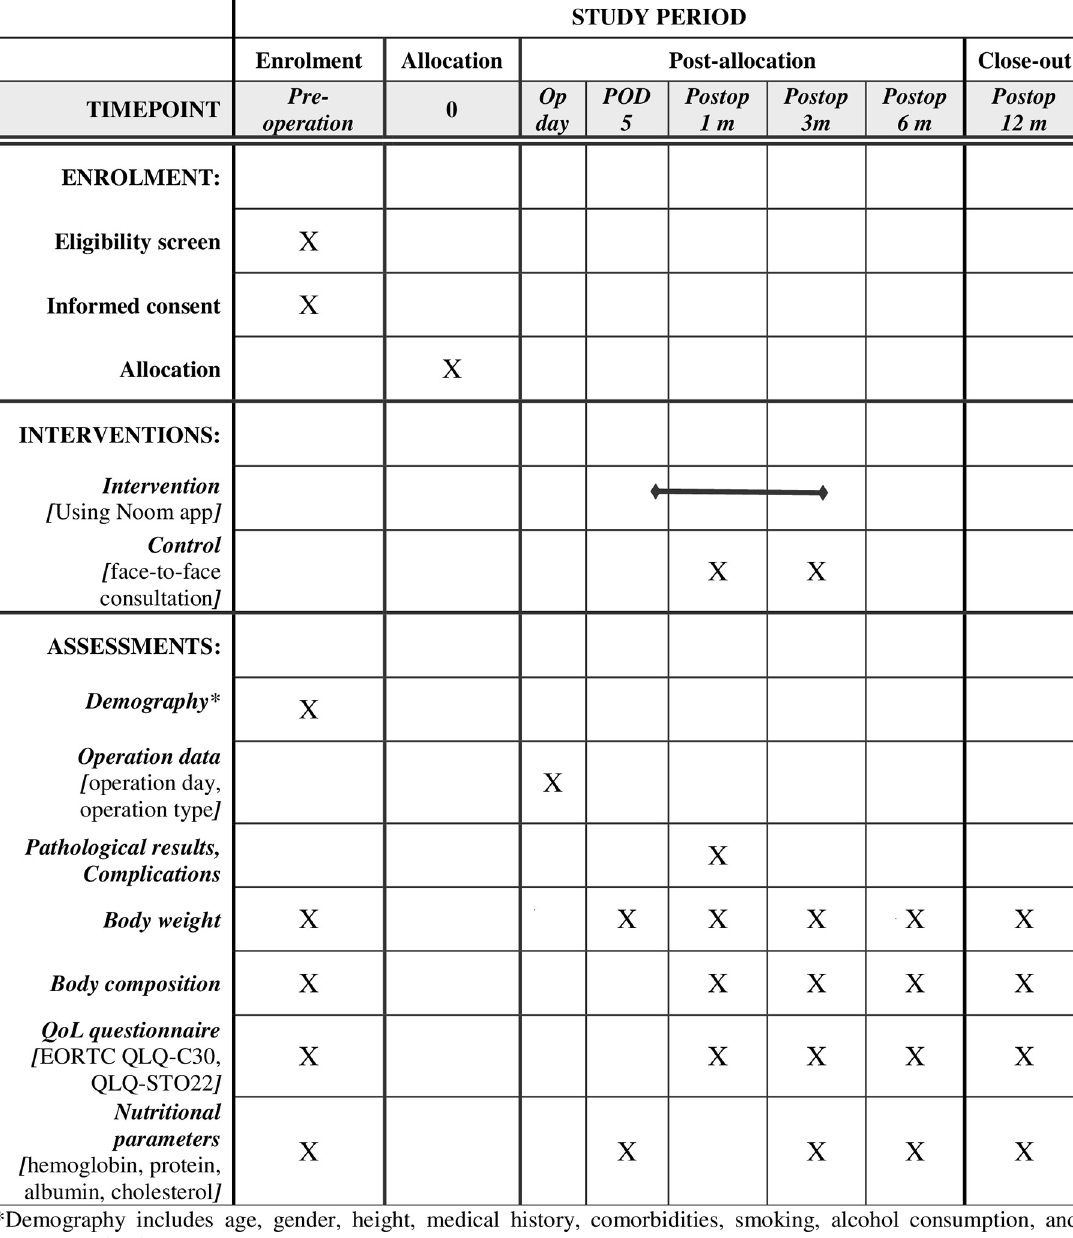
Fig 3. Schedule of enrolment, intervention, and